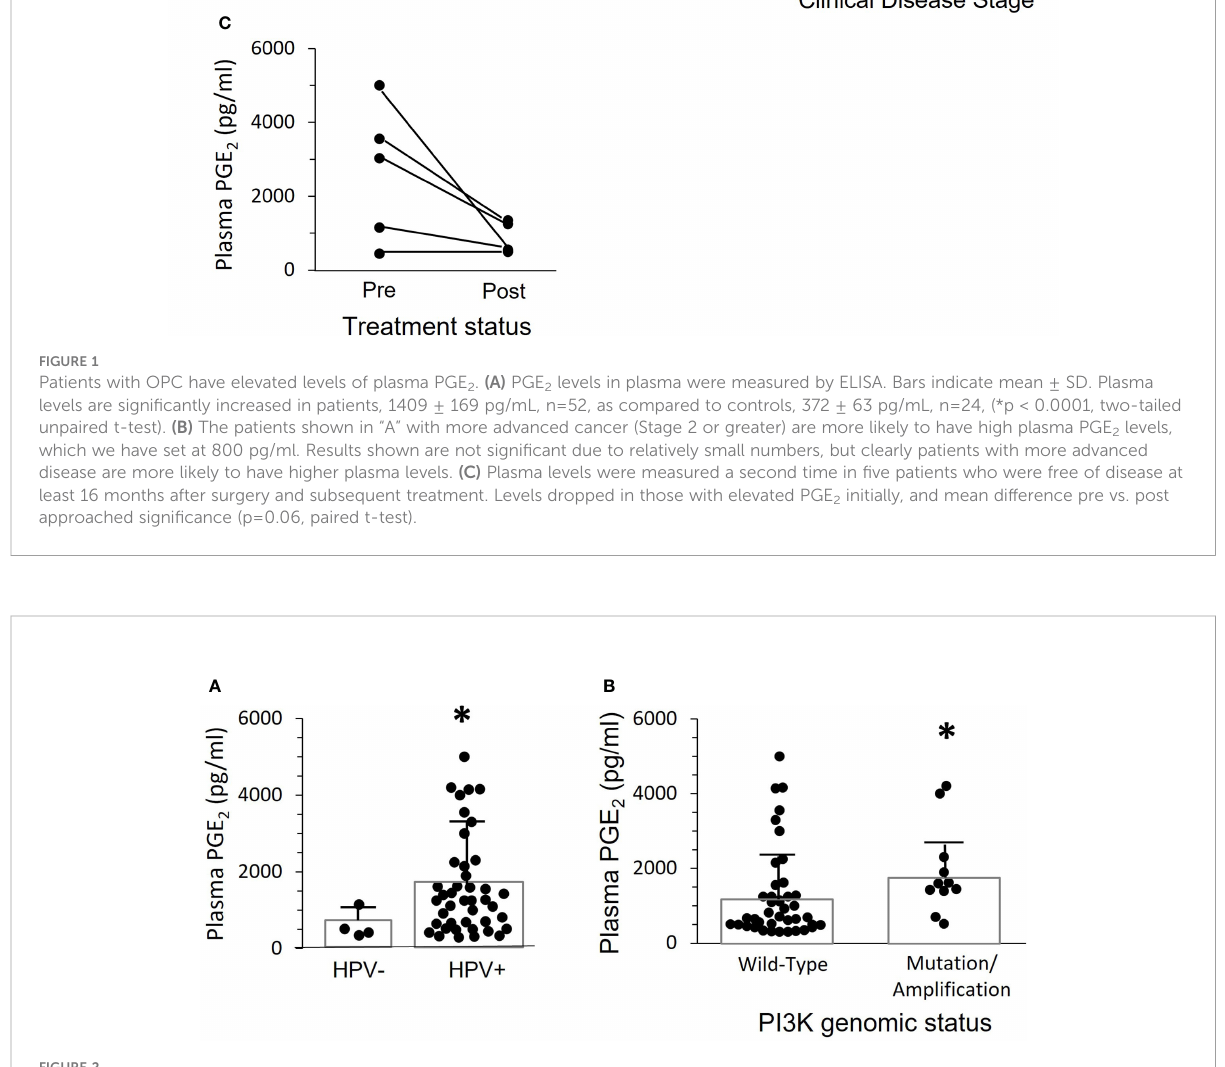
FIGURE 2 Plasma PGE 2 levels correlate with the presence of HPV and gain of function mutations or ampli fi cation of PIK3CA . (A) PGE 2 levels for the 52 patients in Figure 1 were separated based on presence of HPV-16 in tumor biopsies. There was a signi fi cant difference between the two groups (*p=0.006, two-tailed unpaired t-test with Welch ’ s correction). (B) PGE 2 levels were compared in 11 patients with either gene mutations or copy number ampli fi cations, and 41 patients with normal sequence and copy-number. Bars indicate mean ± SD. Levels were signi fi cantly higher in the group with altered PIK3CA , 1919 ± 357 pg./mL, compared to wild-type, 1272 ± 188 pg/mL, (*p=0.014, Mann Whitney test).